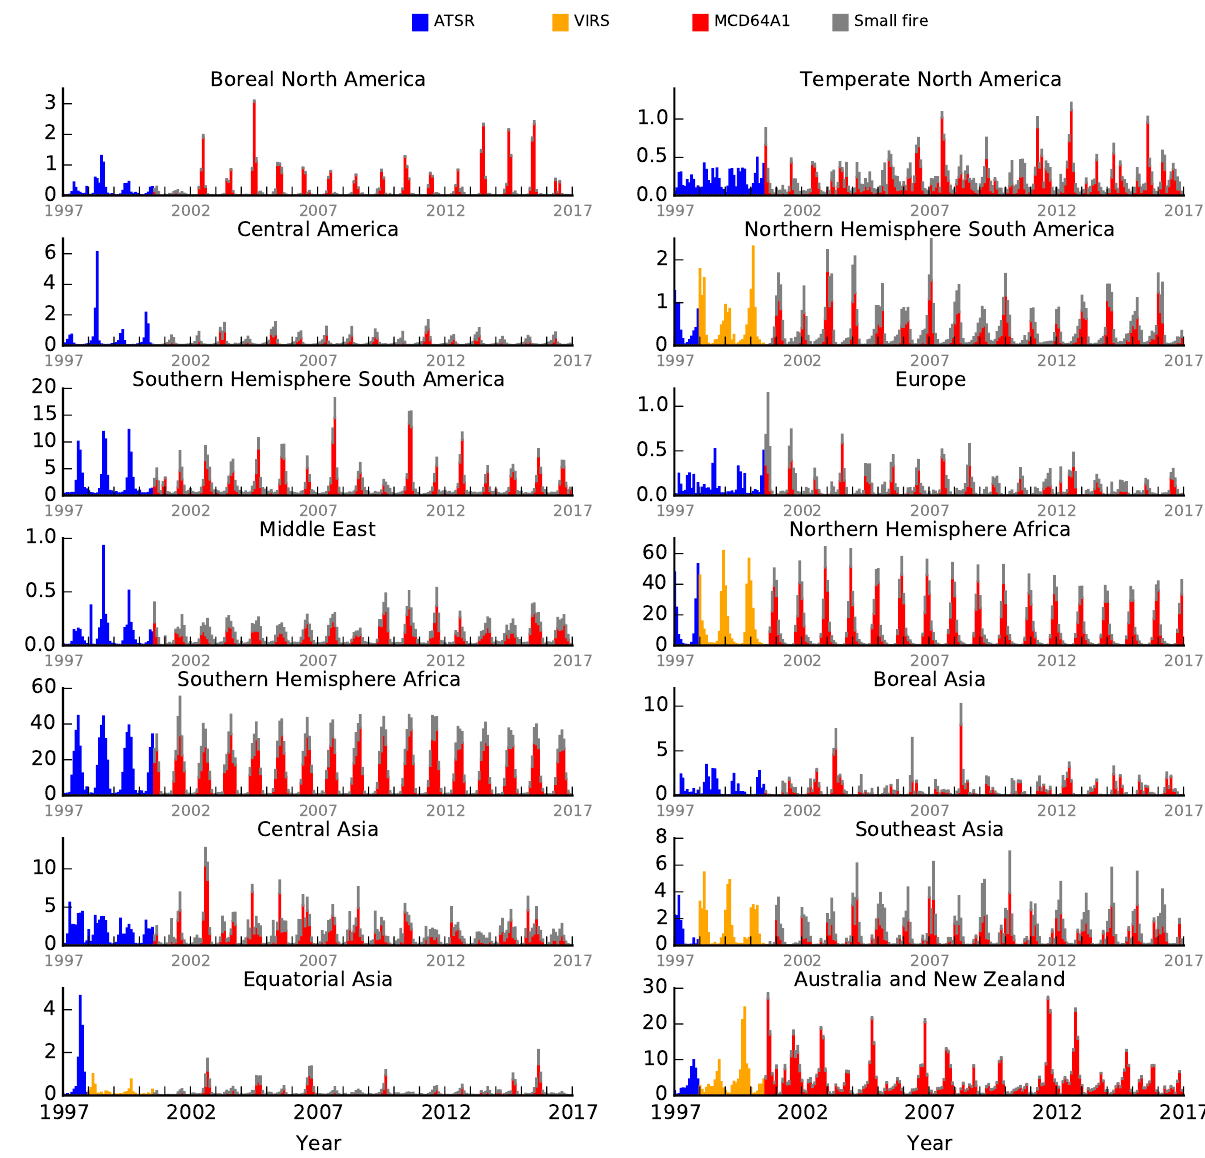
Figure 4. Regional time series (1997–2016) of GFED4s monthly burned area. The different colors indicate the contribution from each of the different data sources and methodologies (ATSR, TRMM-VIRS, 500m MCD64A1, and small fires) used to produce the entire